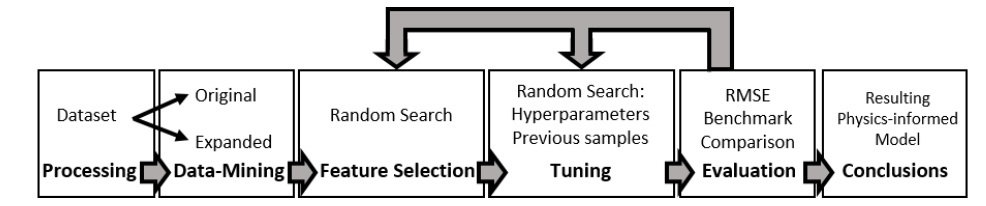
Figure 6. Methodology